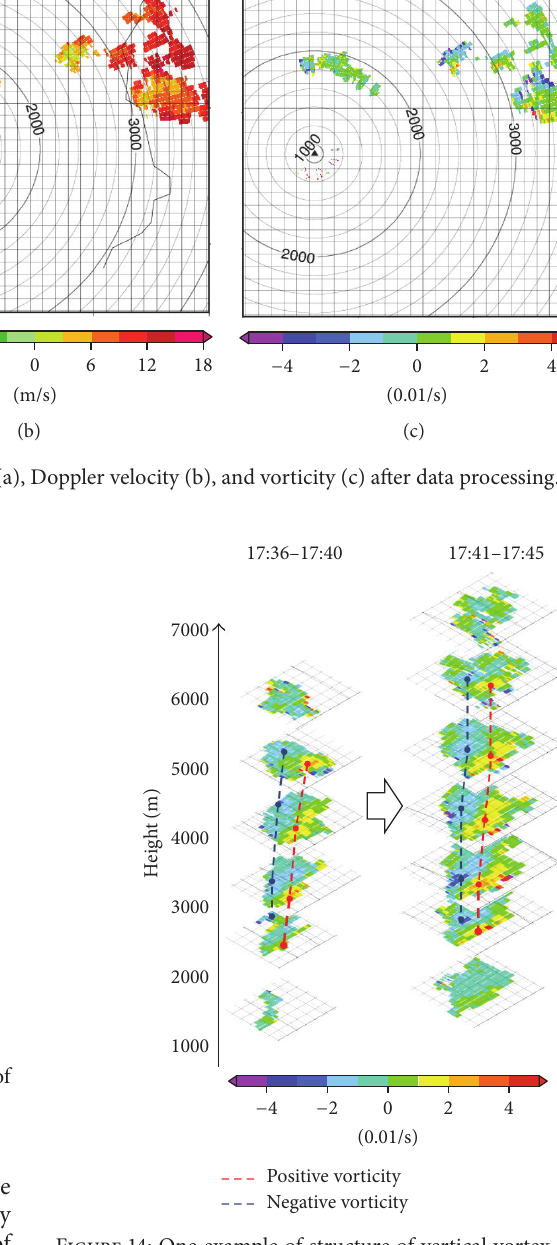
Figure 14: One example of structure of vertical vortex tube in the rain-cell of the event 15 in Table 3. The red lines show positive vorticity and the blue lines show negative